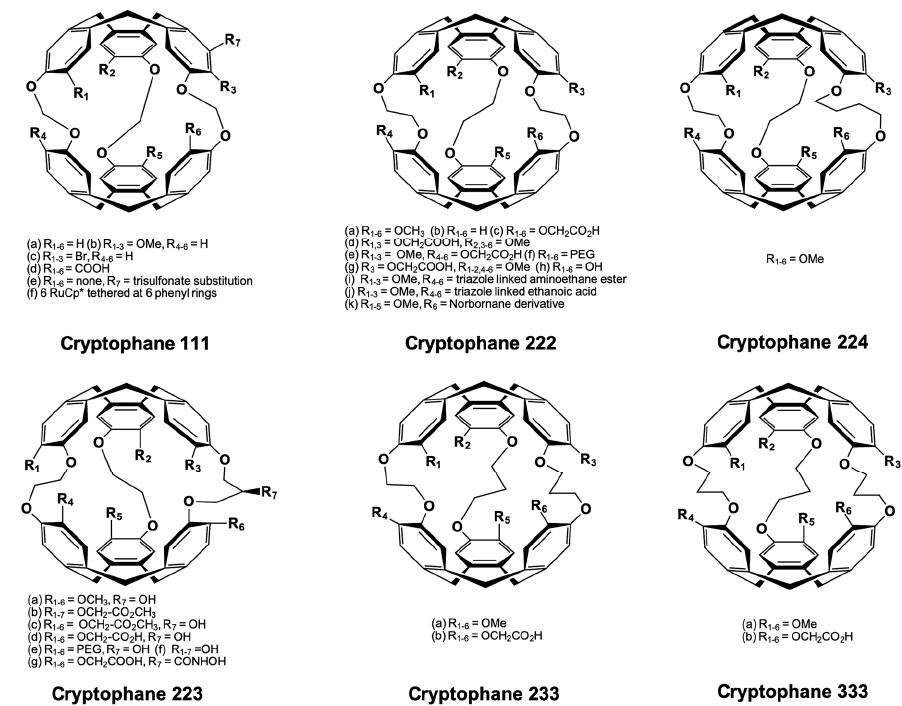
Figure 6. Different cryptophanes and their derivatives that were evaluated as potential 129 Xe hosts. All above cryptophanes are shown to bind hp 129 Xe to a varying degree which was reflected through the observed difference in the binding constants.